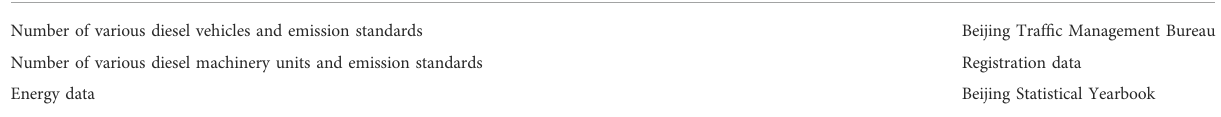
TABLE 1 Data sources of activity levels for mobile-source emissions.